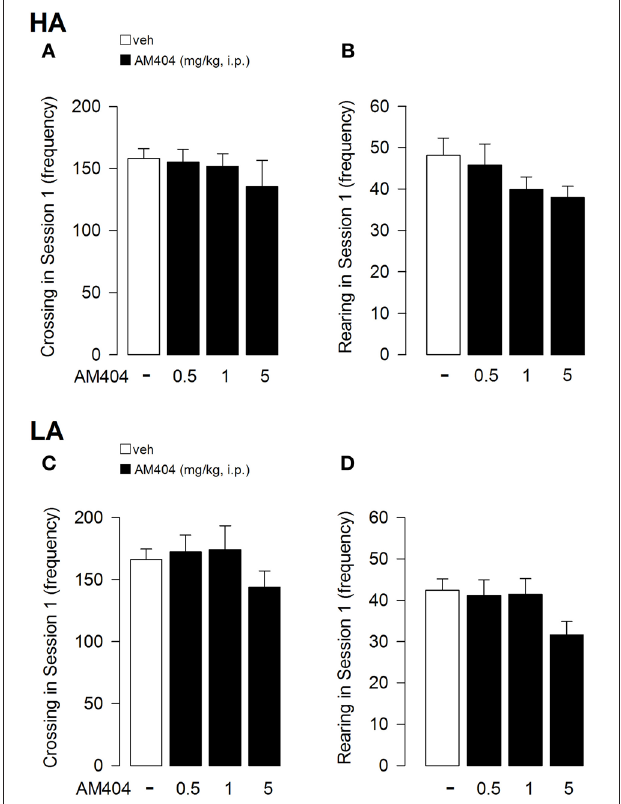
FIGURE 4 | Effects of AM404 administration on locomotor activity in rats exposed to high arousal (HA) or low arousal (LA) conditions. Number of crossing (A) and rearing (B) of rats exposed to HA or LA conditions (C, D, respectively ) in session 1. Data are expressed as mean ±